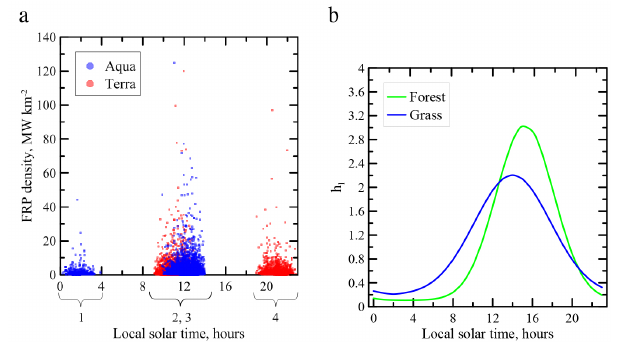
Figure 3. (a) Daily maximum FRP densities derived from the MODIS measurements on board the AQUA and TERRA satel- lites over the study region (see red rectangle in Fig. 2a) as a function of the local solar time in May–September 2012; each point repre- sents one selected measurement in a grid cell of 0 . 2 ◦ × 0 . 1 ◦ . Note that due to variable observation conditions and a low temporal res- olution of the MODIS measurements, the daily maximum of FRP from a given fire is not necessarily always detected at the time of day when the actual FRP is largest. (b) Estimated regional average diurnal variations of